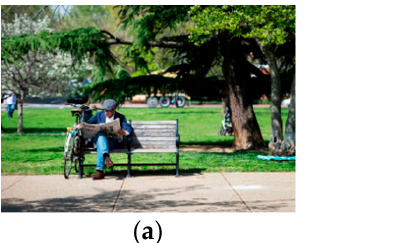
Figure 10. Object recognition results: ( a ) first set (target object: person); ( b ) second set (target object: traffic light).